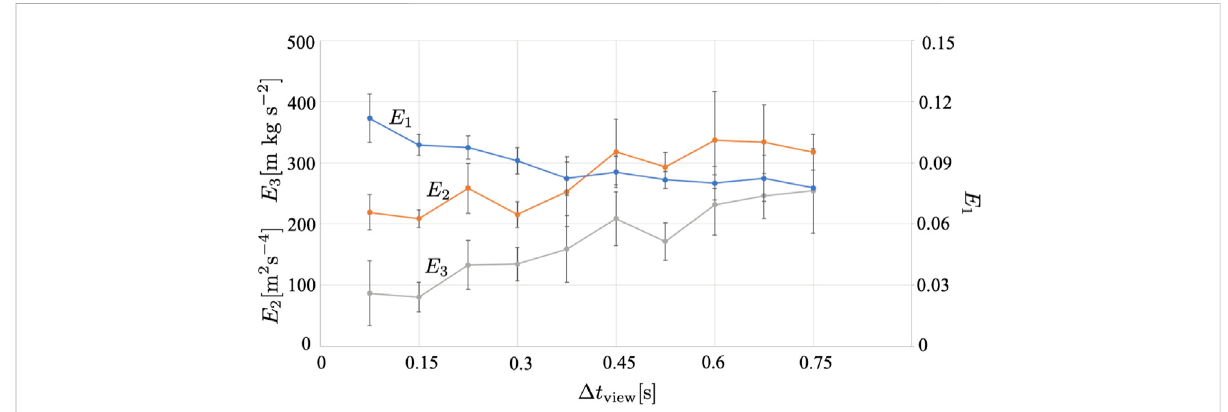
FIGURE 12 Resultwhenthetime interval for theupdate ofthefan-shaped observation range Δ t view isvaried. The average over fi vetrialsisshown. Theerror bars denote the standard